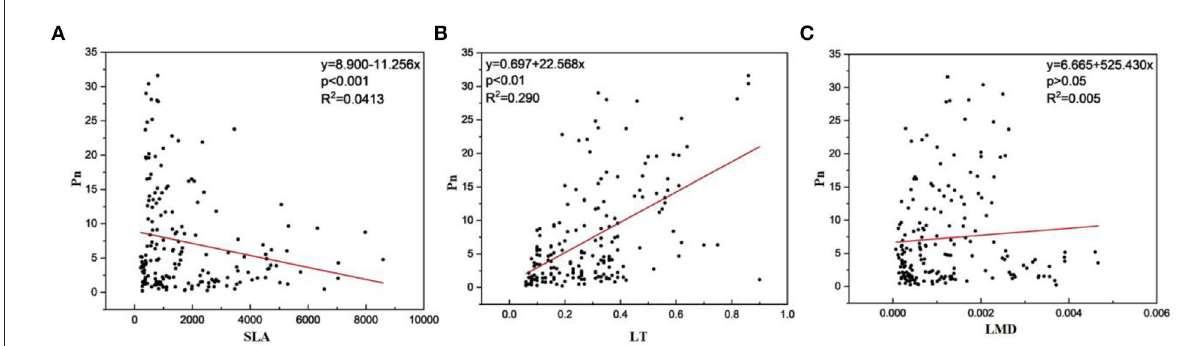
FIGURE3 Relationship between plant leaf phenotypes and net photosynthetic rate in the fluctuating zone of the Three Gorges Reservoir area. (A) The relationship between specific leaf area and net photosynthetic rate. (B) The relationship between leaf thickness and net photosynthetic rate. (C) The relationship between leaf mass density and net photosynthetic rate. SLA, specific leaf area; Pn, net photosynthetic rate; LT, leaf thickness; LMD, leaf mass density.